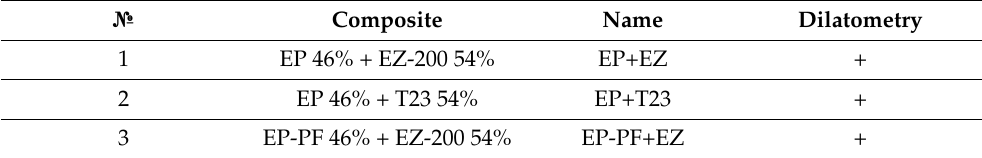
Table 2. Types of GRPs investigated. №